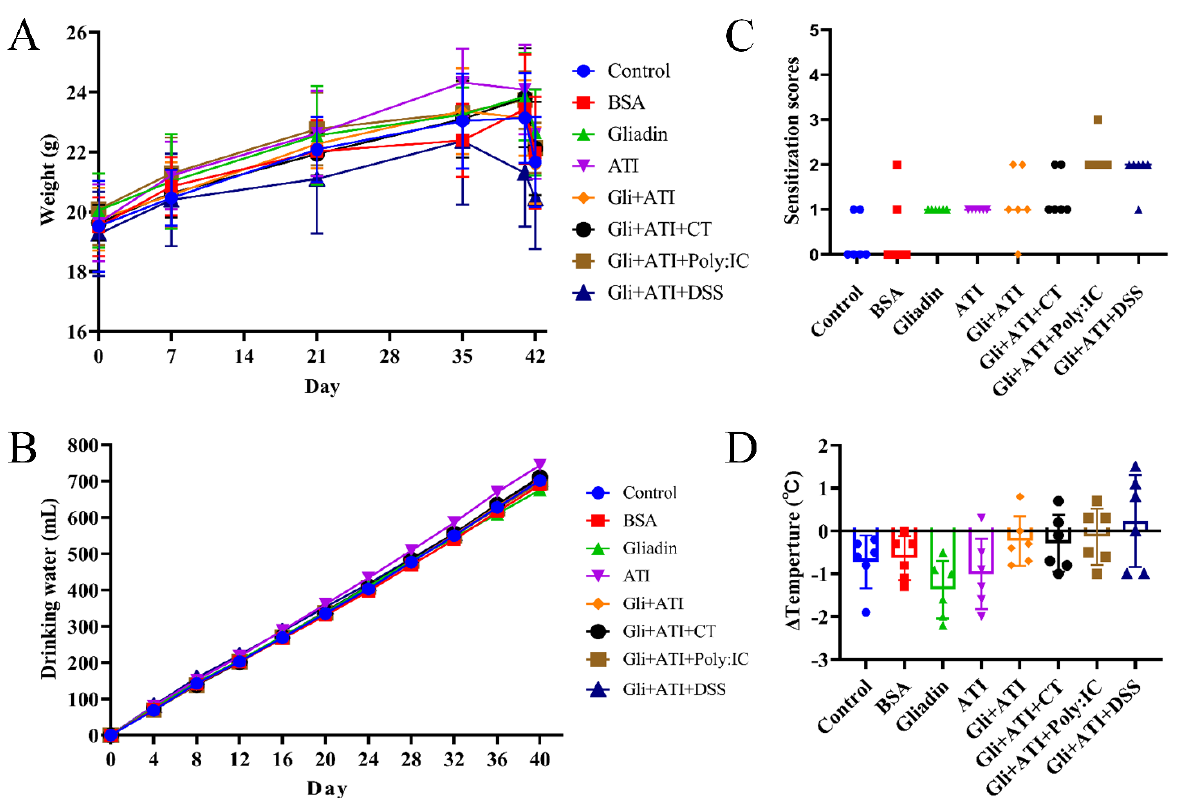
Figure 2. Weight, water consumption, clinical symptoms and body temperature of mice. ( A ) Body weight of mice. ( B ) Water consumption of mice. ( C ) Clinical signs scores of mice. ( D ) Changes of mice body temperature. (ΔTemperature = body temperature of mice after stimulation - body temperature of mice before stimulation). Footnote: Clinical symptoms score: (0) No symptoms; (1) Scratching nose and mouth; (2) Swelling around the eyes and mouth, diarrhea, reduced activity or walking in place, higher breathing rate; (3) Shortness of breath, wheezing, blue rash around the mouth and tail; (4) Loss of consciousness, tremors or cramps; (5) Death by shock.